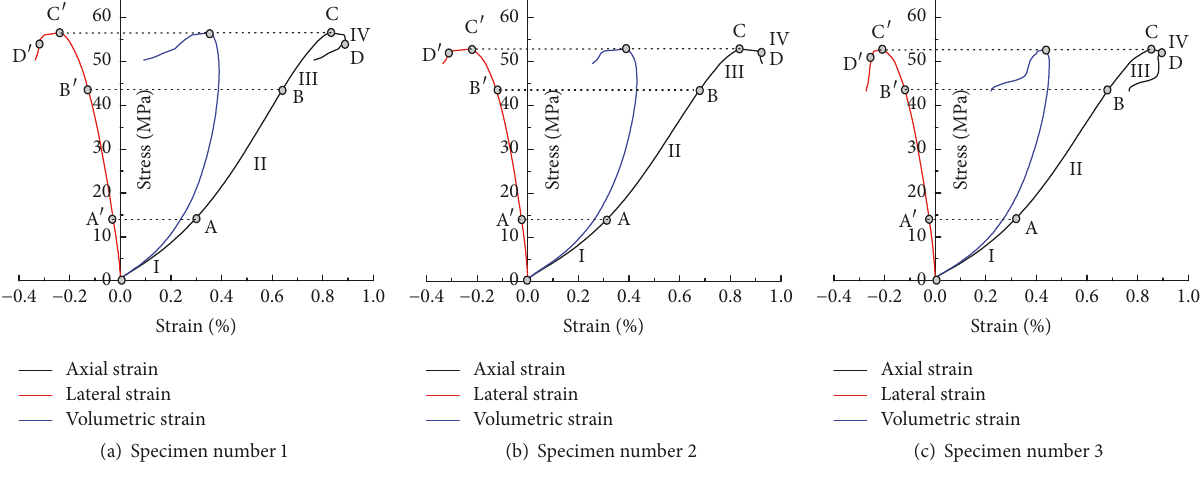
Figure 6: Typical curves of stress versus axial strain of sandstone specimens under compression.